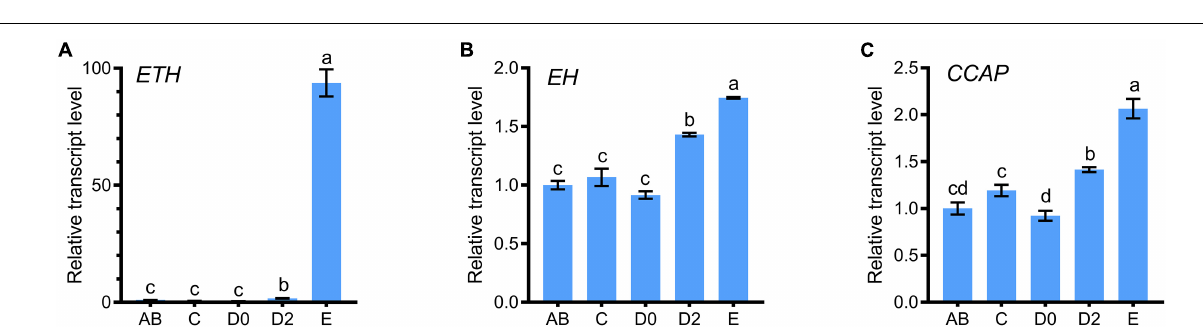
FIGURE 2 | Temporal expression patterns of ETH (A) , EH (B) , and CCAP (C) in S. paramamosain . The cDNA templates were derived from the post-molt stage (AB), intermolt stage (C), the early premolt stage (D0), the late premolt stage (D2) and the ecdysis stage (E). For each sample, three independent pools of five individuals were measured in triplicate using real-time quantitative PCR (qRT-PCR). The values were calculated using the 2– (cid:49)(cid:49) CT method. The relative transcript levels of AB were set as 1. The bars represented averages with vertical lines indicating standard deviation (i.e., SD). Different letters indicate significant differences at P < 0.05 computed with ANOVA and the Tukey-Kramer